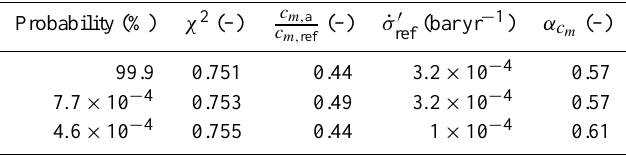
Table 1. Red Flag output for the RTiCM model.